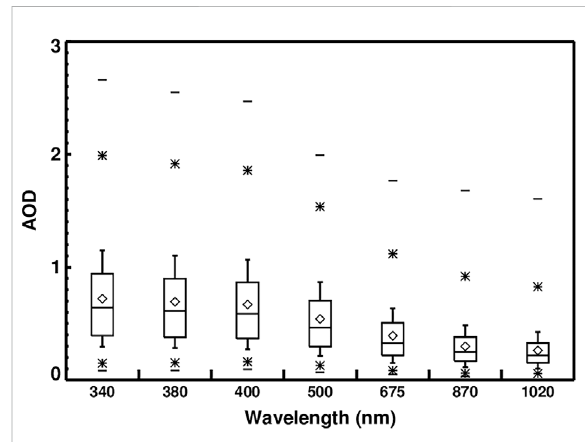
FIGURE 4 AOD at different wavelengths in XAUT during 2015 – 2018. Thehorizontallineinthemiddle ofthebox represents themedian, while the upper and lower horizontal lines represent the 25th and 75th percentiles, respectively. The diamond represents the mean; the uppermost and lowest short lines represent the maximum and minimum values; and the asterisks represent the 1 – 99%